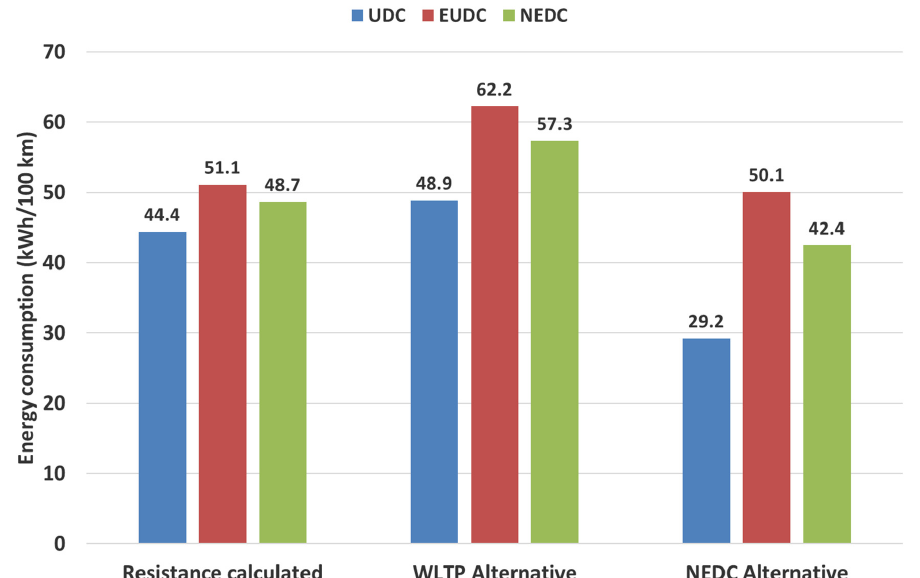
Figure 6. Comparison of energy consumption for individual phases of the cycle (UDC, EUDC) and the entire NEDC taking into account the dynamometer loading method. The energy consumption is proportional to the fuel consumption of the car engine, Table 4. Relationship between resistance forces method and engine fuel the results of which are shown in Table 4. As with CO 2 , the largest differences in fuel consumption values for the analyzed methods occur for the urban phase of the UDC, which is also related to the largest differences in drag function values for lower speeds.